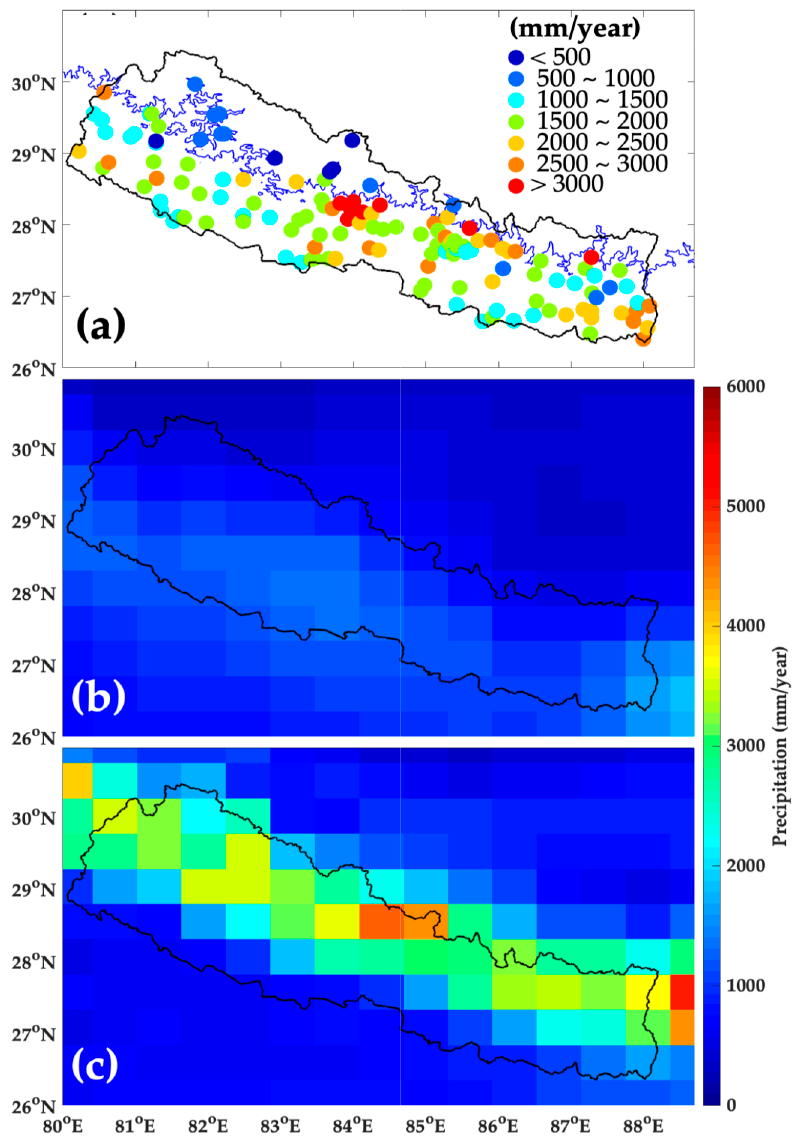
Figure 5. Spatial distribution of mean annual precipitation (mm / year) in ( a ) Observation, ( b ) MERRA-C, and ( c ) MERRA-NC during 2000-2018.